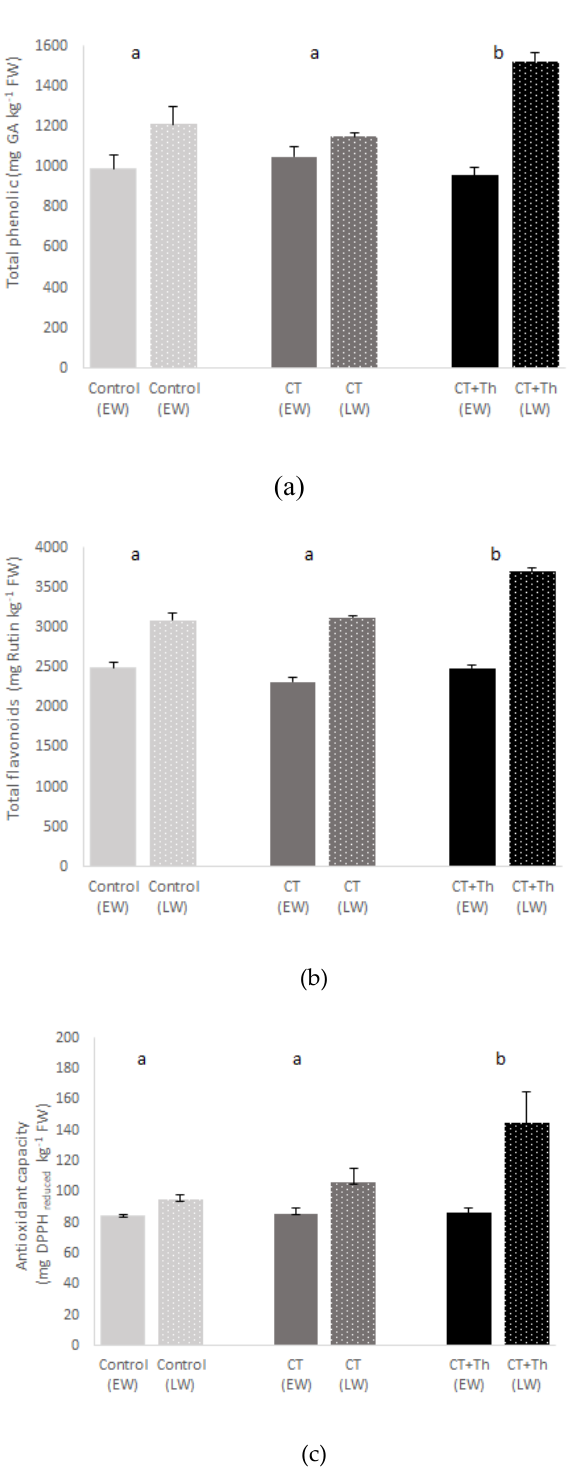
Figure 2. Effect of different compost tea (CT) treatments on total phenolic ( a ) total flavonoids ( b ) and antioxidant capacity ( c ) of baby spinach in both experiments. Bars are mean values n = 3. Error bars indicate standard deviation. Control: sprayed distilled water (12 m 3 per ha); CT: sprayed compost tea (12 m 3 per ha); CT + Th: sprayed compost tea (12 m 3 per ha) and T. harzianum T-78 (5 × 10 8 cfu mL − 1 per ha). EW: early winter and bars without points; LW: late winter and bars with points. Di ff erent lowercase letters about bars indicate di ff erences between treatments ( p ≤ 0.05) in EW and di ff erent uppercase letters about bars indicate di ff erences between treatments ( p ≤ 0.05) in